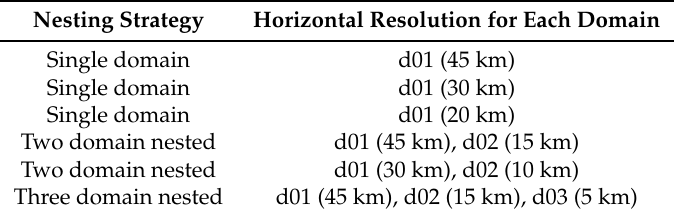
Table 3. Nesting strategy and horizontal resolution for each domain.